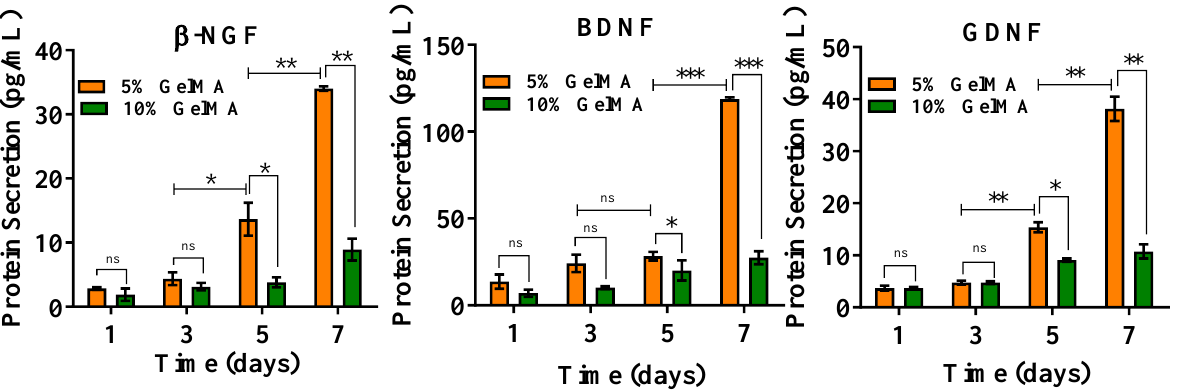
Figure 4. Neurotrophic factors secretion of SCs encapsulated in 5% and 10% GelMA. * P < 0.05, ** P < 0.01, *** P <